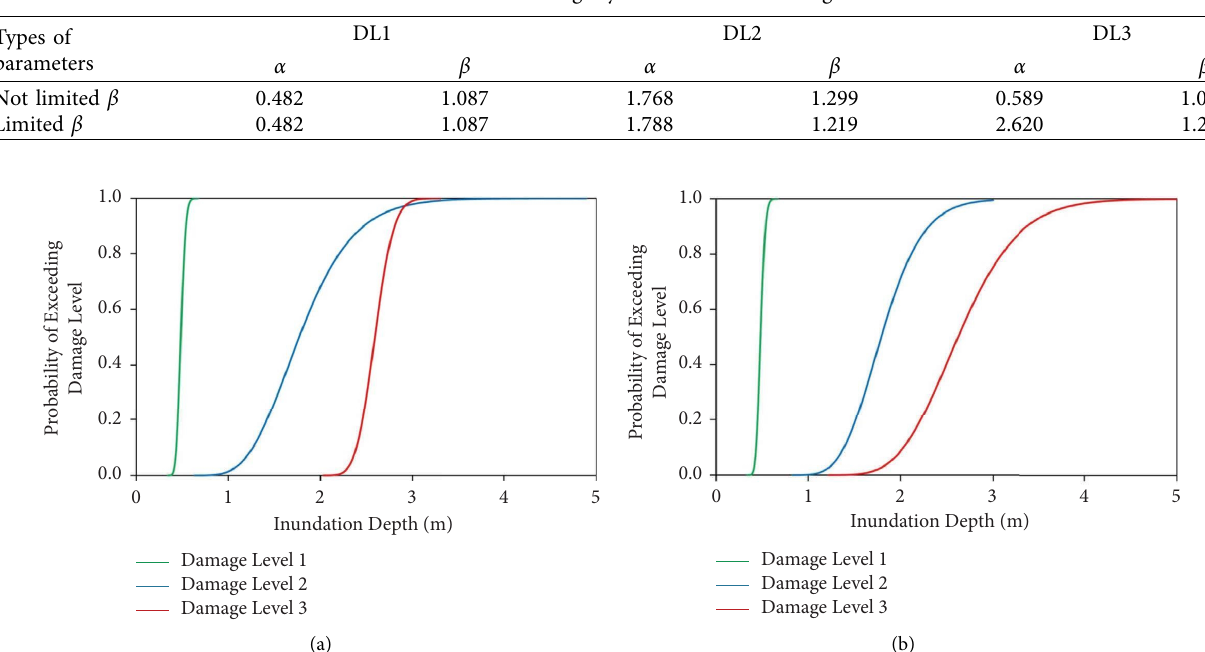
Figure 13: Analytical fragility curve of the building. (a) All damage levels without limiting the standard deviation. (b) All damage levels by limiting the standard